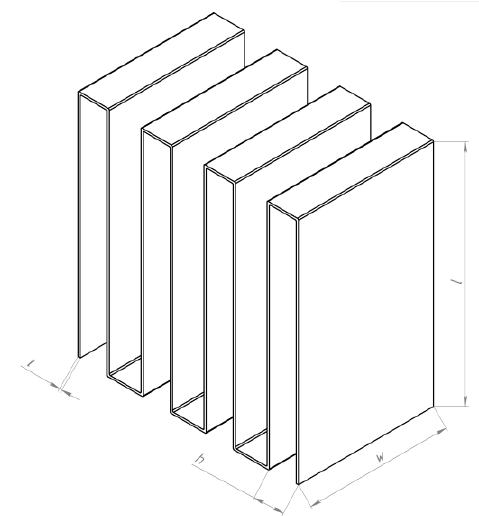
Fig. 3. Appearance of a meander resistive element.